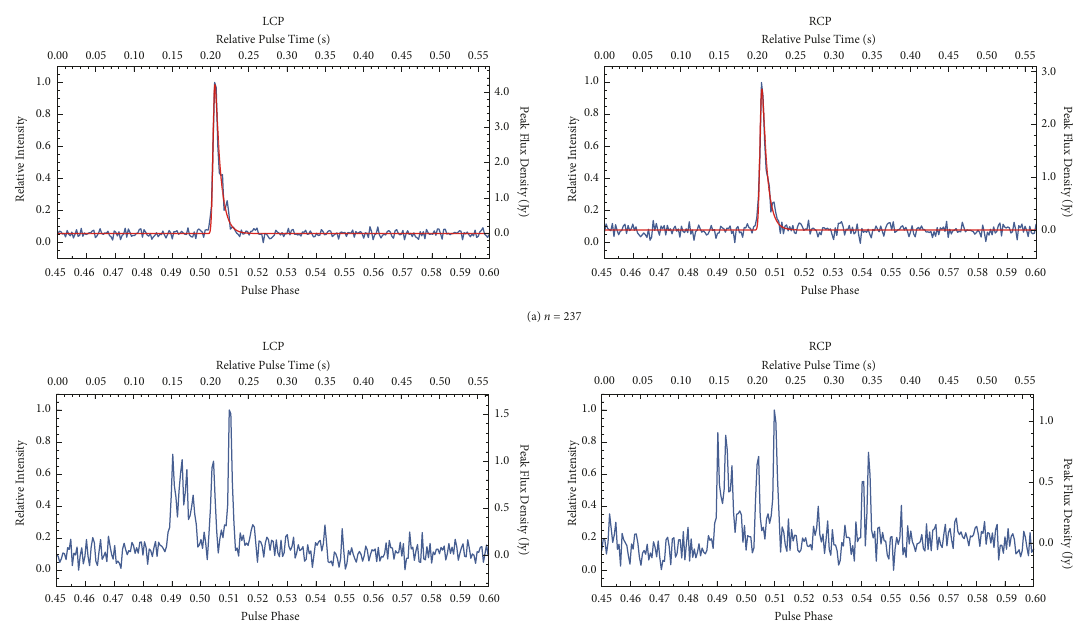
Figure 5: Examples of bright single pulses detected from the GC magnetar at 8.4 GHz during epoch 3 (2016 April 1) with the 70 m DSN radio telescope, DSS-43. We show the single pulse profiles measured in the left circular polarization (LCP) and right circular polarization (RCP) channels during pulse cycles (a) 𝑛 = 237 and (b) 𝑛 = 239, where pulse numbers are referenced with respect to the start of the observation. The best-fit thin scattering screen model, described in the Appendix of Pearlman et al. [13], is overlaid in red on the single pulses in the top row. A pulse broadening timescale of 𝜏 LCP 𝑑 = 7.1 ± 0.2 ms and 𝜏 RCP 𝑑 = 6.7 ± 0.3 ms was measured in the corresponding polarization channels [13]. This figure was adapted from Pearlman et al.